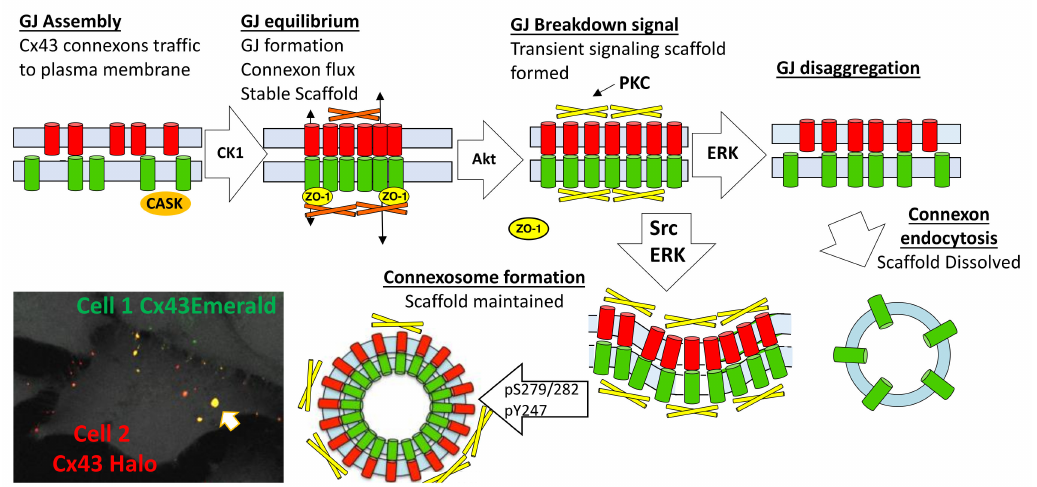
Figure 8. Model incorporating some known e ff ectors for Cx43 life cycle and gap junction assembly and turnover. Arrow in left bottom indicates a yellow internalized connexosome.